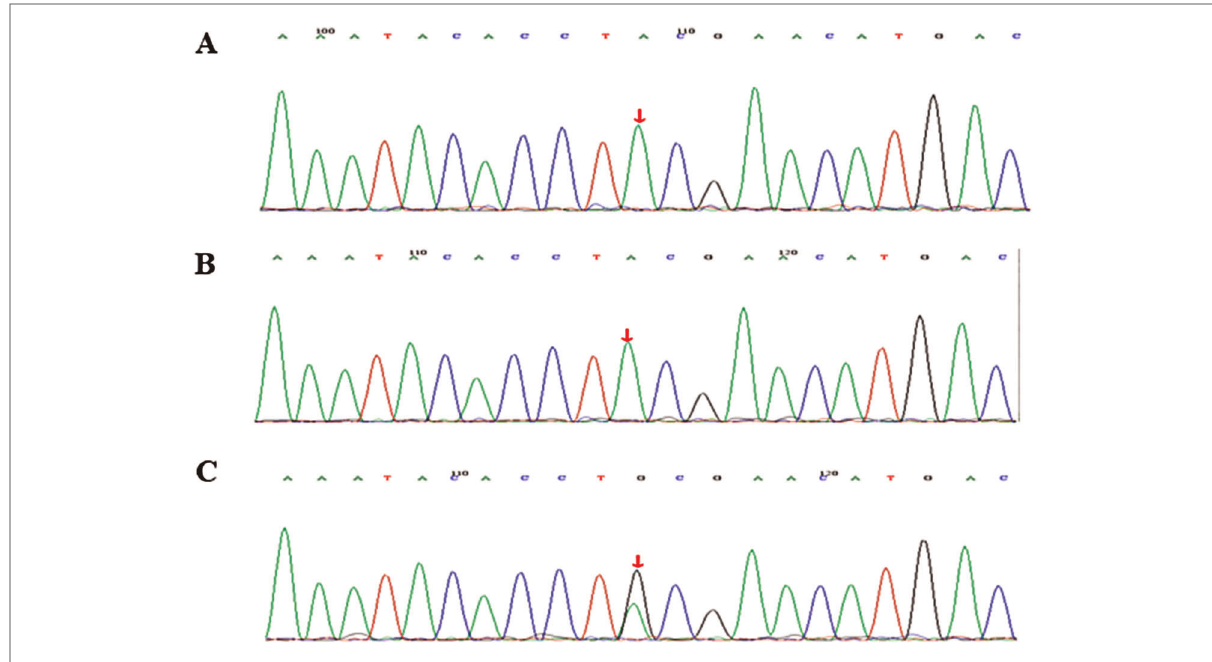
FIGURE 1 Molecular characterization of a family with STAT1 gain-of-function mutation. Sequence chromatogram showing a missense variant c.866A>G, p.Y289C. The variant was heterozygous in the proband ( C ). Sanger sequencing results of his father ( A ) and mother ( B